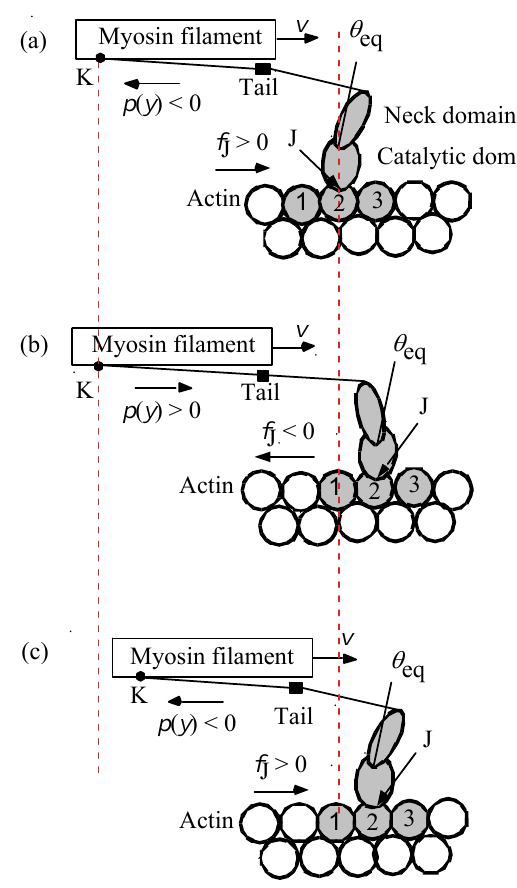
Figure 2. MA complex (shadowed) and its step motion along the actin filament (after 3 Figure 6 of [2]). A myosin head is expressed as neck domain plus catalytic domain and the as 1, 2 and 3. (a) Just before the myosin head moves to the right; actin molecules in MA 3 (b) Just after the head (and the complex MA ) moves to the new position; (c) The head 3